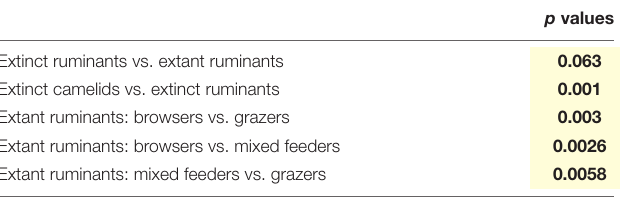
TABLE 3 | Summary of one-way PERMANOVAs run with all row scores obtained from the correspondence analysis (permutation N = 9999) to test for differences between groups of